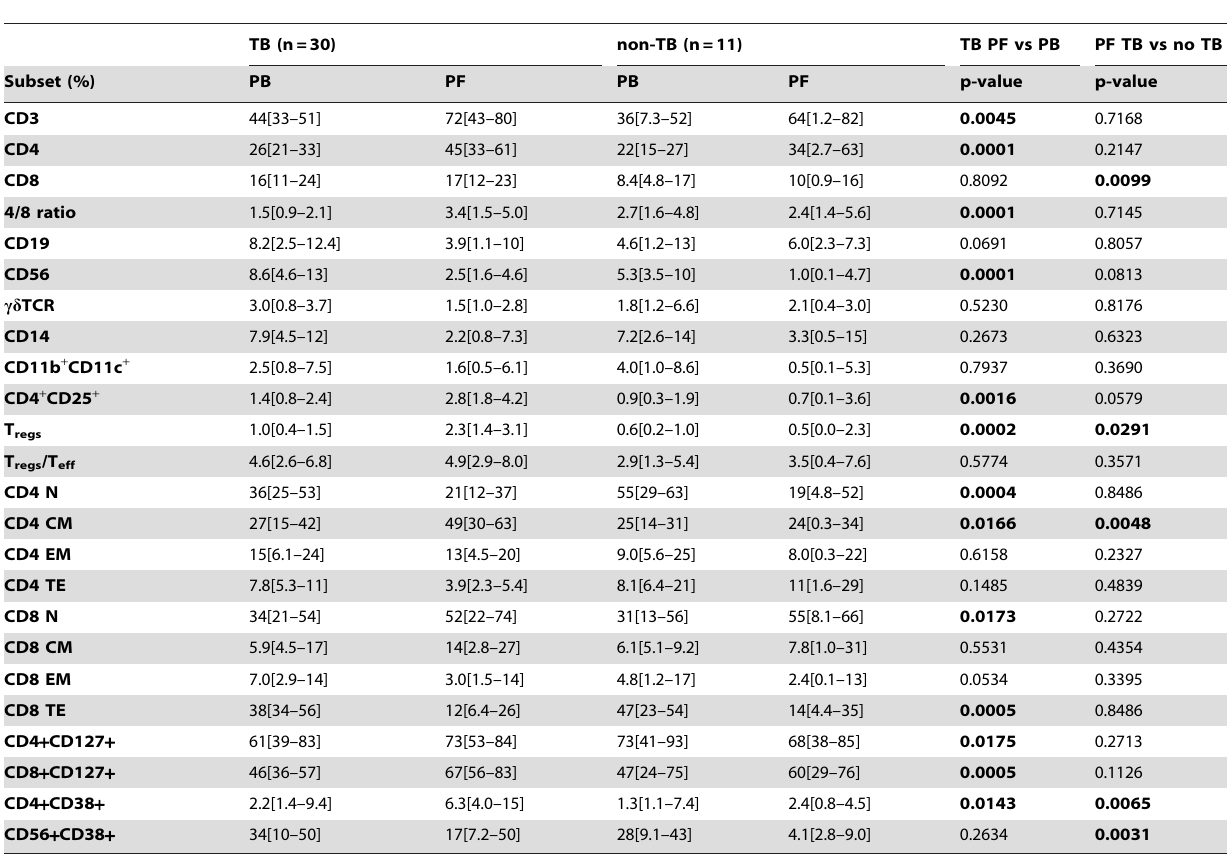
Table 2. Comparison of immune subsets in peripheral blood and pleural fluid of TB and non-TB